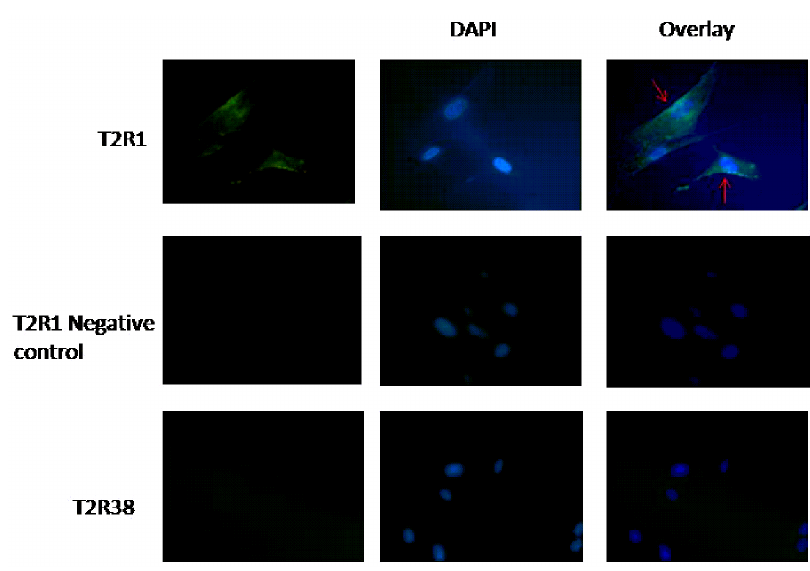
Figure 4. Immunofluorescence showing expression of T2R1 in hPASMCs. hPASMCs were processed by standard immunofluorescence microscopy as described in the methods. T2R1 antisera was utilized to identify the indicated protein (first row). The negative control (second row) utilized an isotype-matched non-specific IgG as the primary antibody, and T2R38 antisera (third row) showed no signals. Rabbit anti-human T2R1 was visualized with goat anti-rabbit Alexa 488 antibody (green) and nuclei were stained with DAPI (blue). Merged images show that T2R1 localized partly on the cell surface of hPASMCs cells as indicated by arrows.